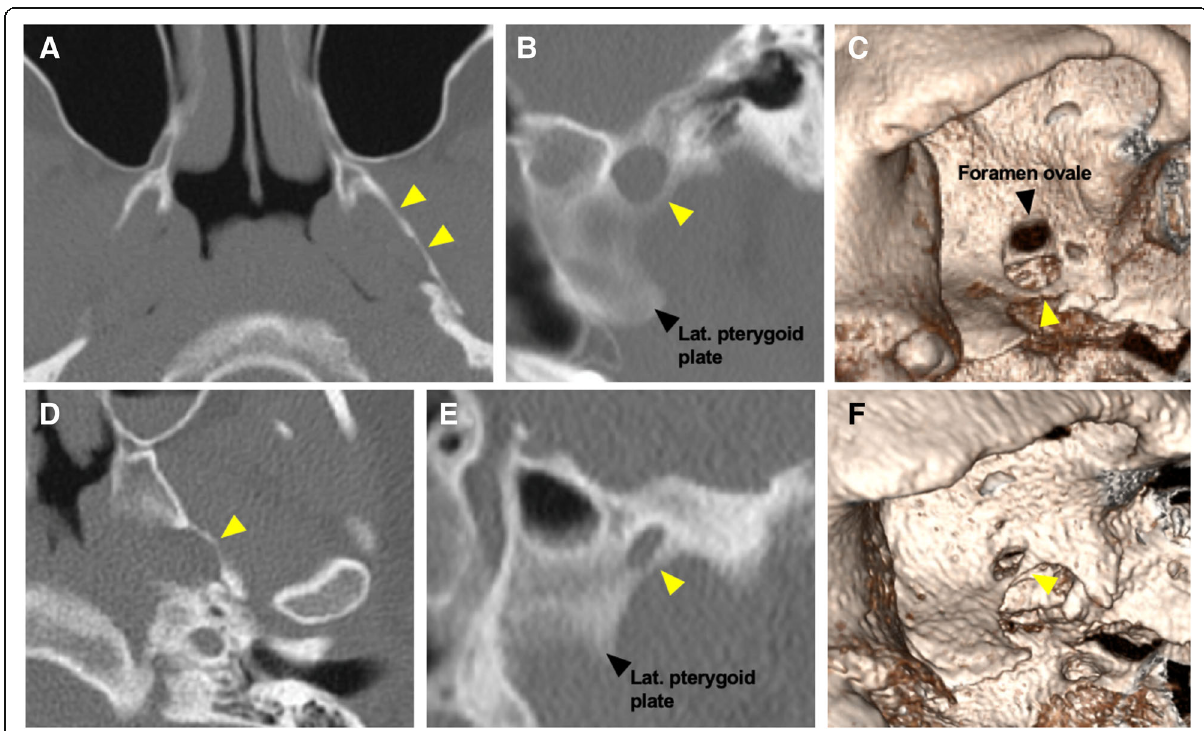
Fig. 3 Mineralised pterygospinous and pterygoalar ligaments. Axial ( a ), oblique sagittal MIP ( b ), and 3D ( c ) volume CT reconstructions demonstrating a completely mineralised left pterygospinous ligament (yellow arrowheads). The foramen ovale is demonstrated on the 3D reconstruction. Axial ( d ), oblique sagittal MIP ( e ), and 3D ( f ) volume CT reconstructions demonstrating a completely mineralised left pterygoalar ligament (yellow arrowheads). The foramen ovale is